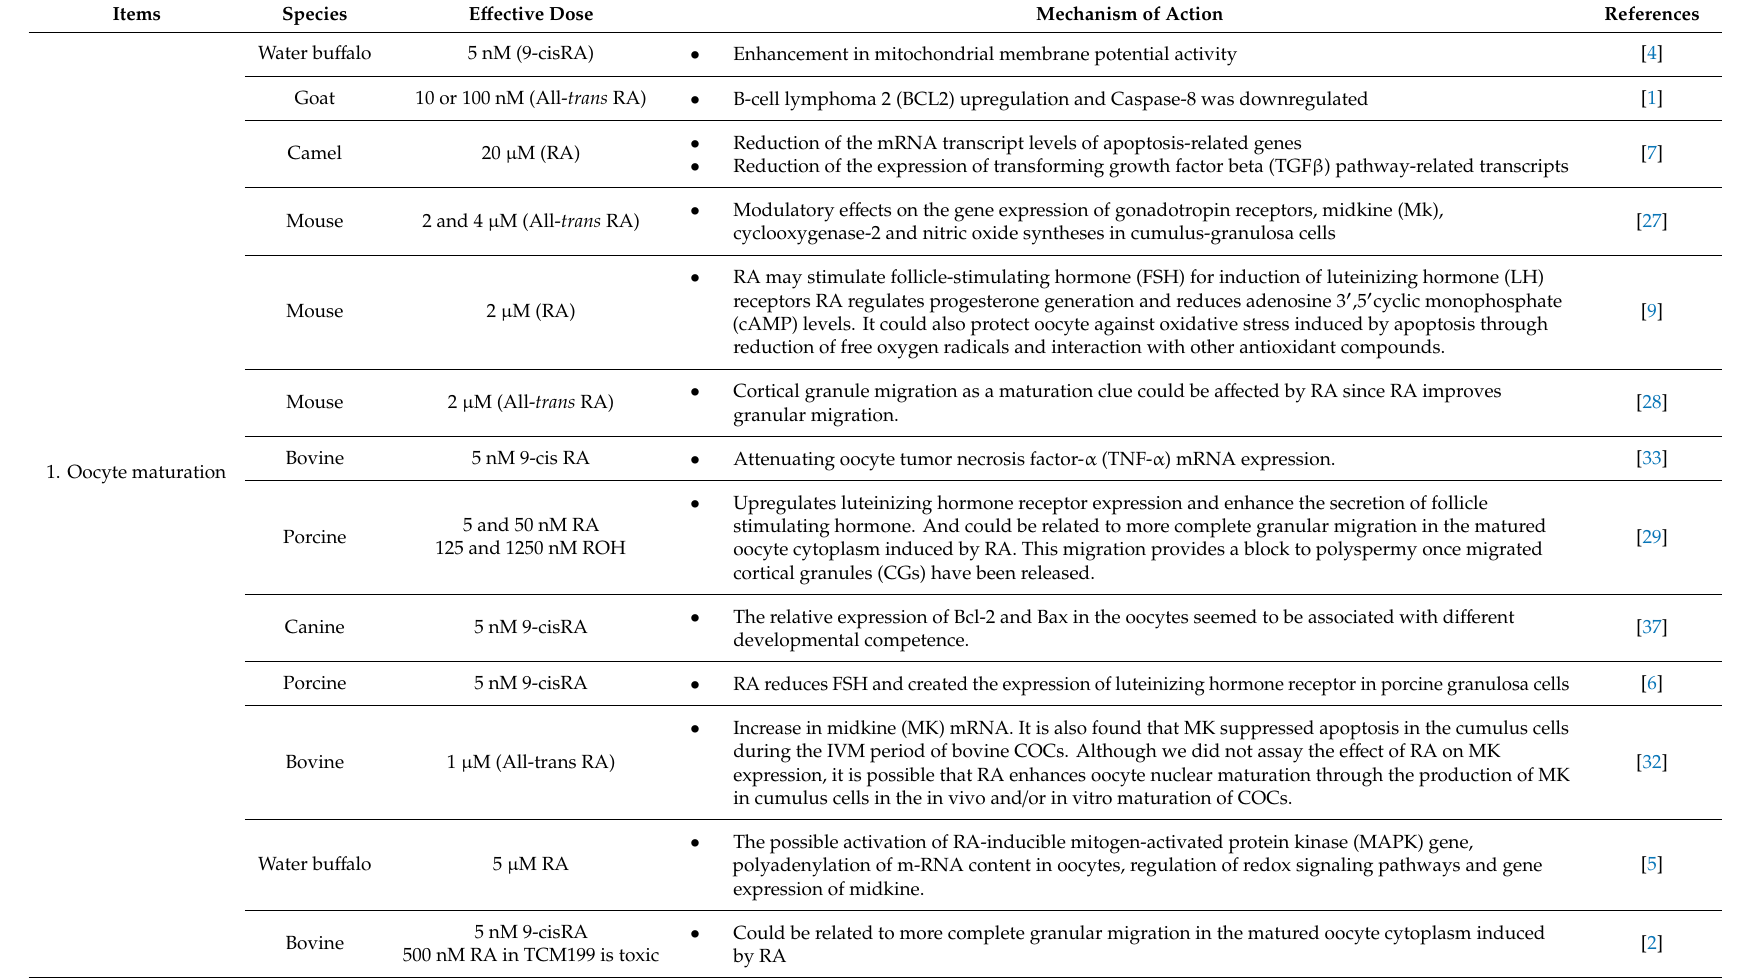
Table 1. Retinoic Acid (RA) supplementation in IVM and the e ff ect on oocyte maturation, fertilization / cleavage, and blastocysts development.